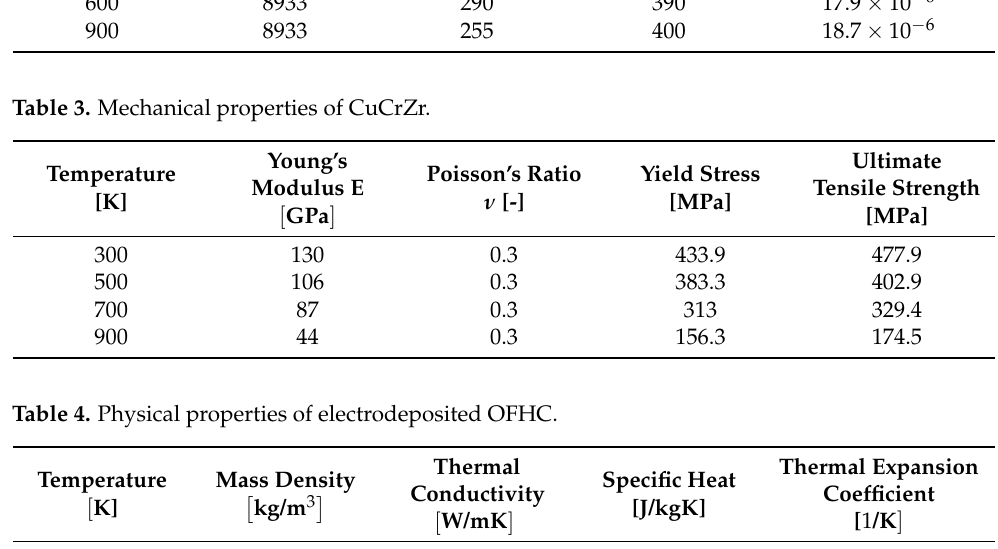
Table 3. Mechanical properties of CuCrZr. Table 5. Mechanical properties of the electrodeposited